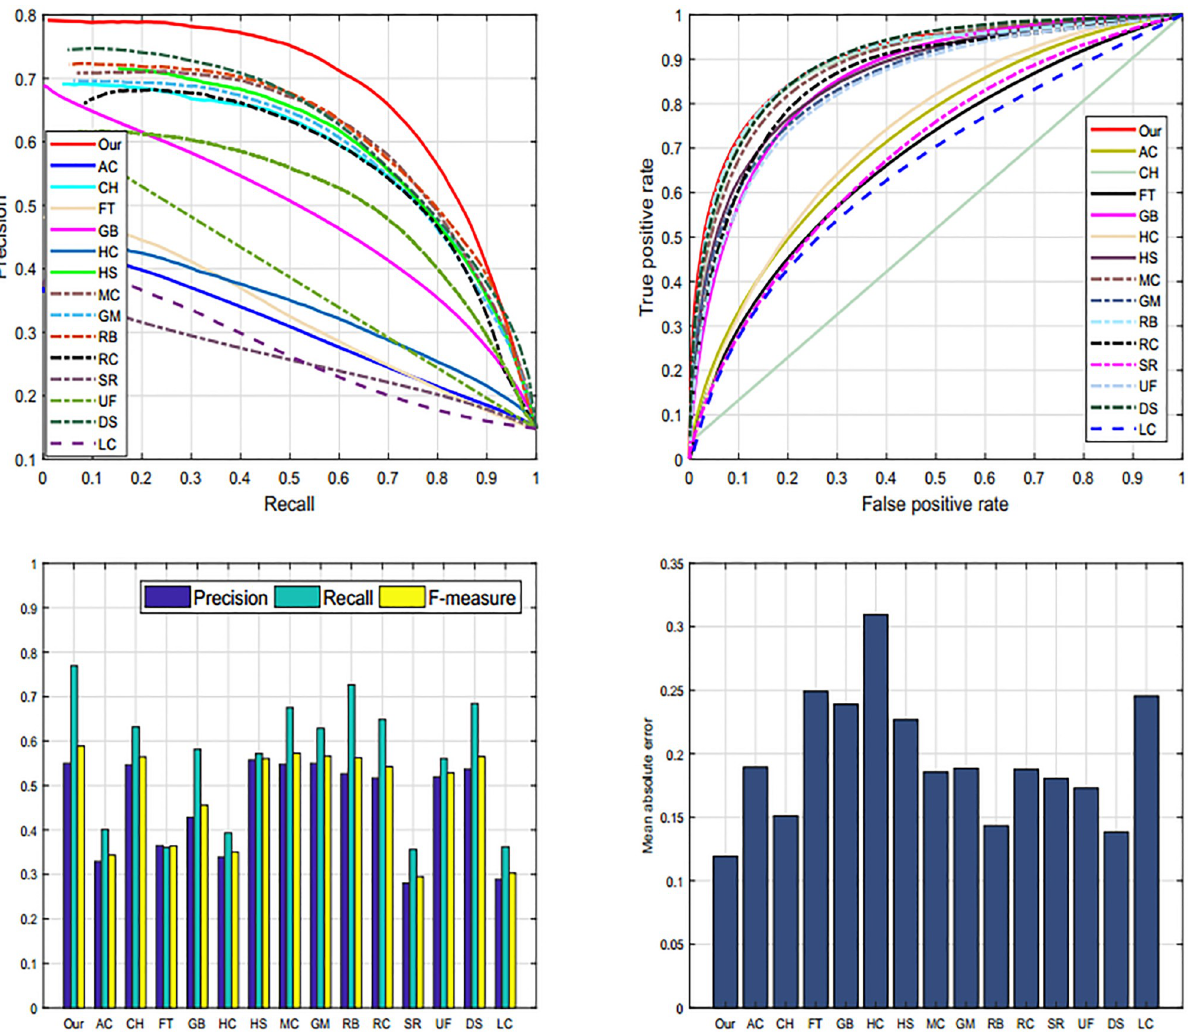
Fig 11. Graphical comparison of our method with current schemes such as: AC [39], CHM [44], FT [35], GB [9], HC [10], HS [36], MC [40], GM [5], RB [45], RC [10], SR [43], UF [41], DS [6], LC [42], and our proposed model on the DUT-OMRON database [5]. https://doi.org/10.1371/journal.pone.0213433.g011 PLOS ONE | https://doi.org/10.1371/journal.pone.0213433 March 28,